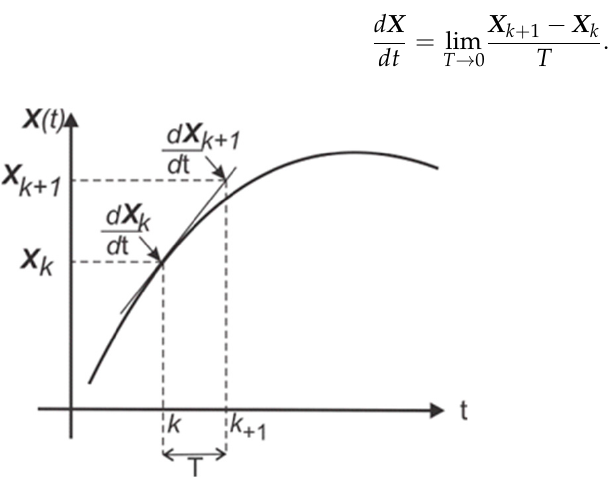
Figure 4. Approximation using forward and backward Euler method.